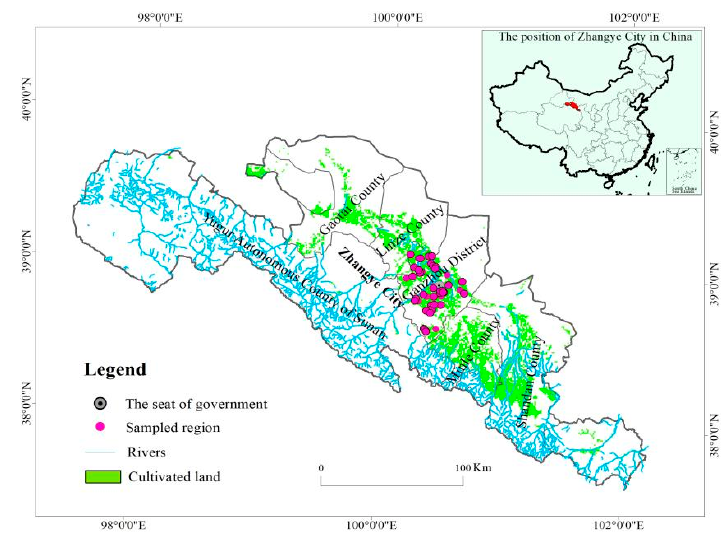
Figure 2. Distribution of study area. Table 1. Settings and variables of the questionnaire.